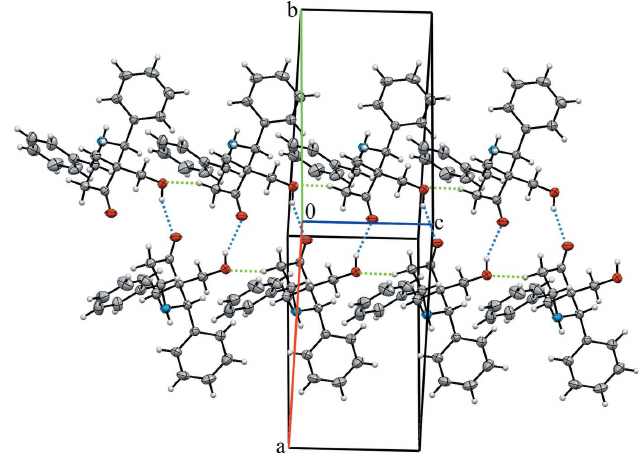
Figure 1 The molecular structure of 3-(hydroxymethyl)-3-methyl-2,6-diphenyl- piperidin-4-one with the atom labelling. Displacement ellipsoids are drawn at the 40% probability level.